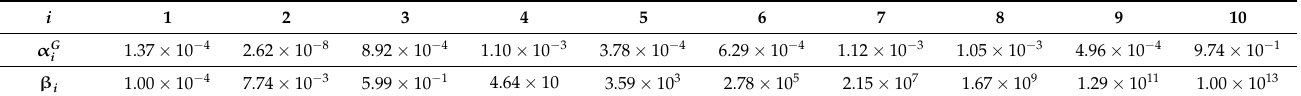
Table 7. Values of viscoelastic constants of the relaxation function for 10 relaxation times.